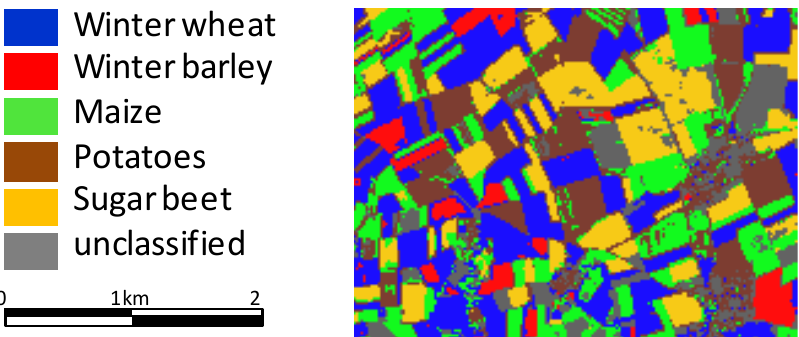
Figure 11. Land cover map derived by the model-supervised classification approach of assigning crop types to the highest average probability at the end of the growing season in 2010.